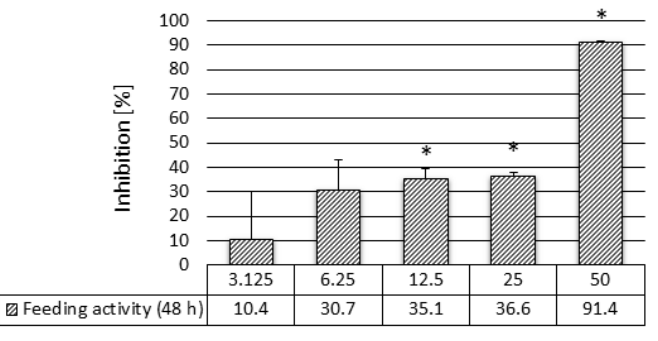
Figure 3. The effect of graphene oxide on the feeding activity of D. magna after 48 h of exposure. Significant effect compared to the control is marked by an asterisk (*).